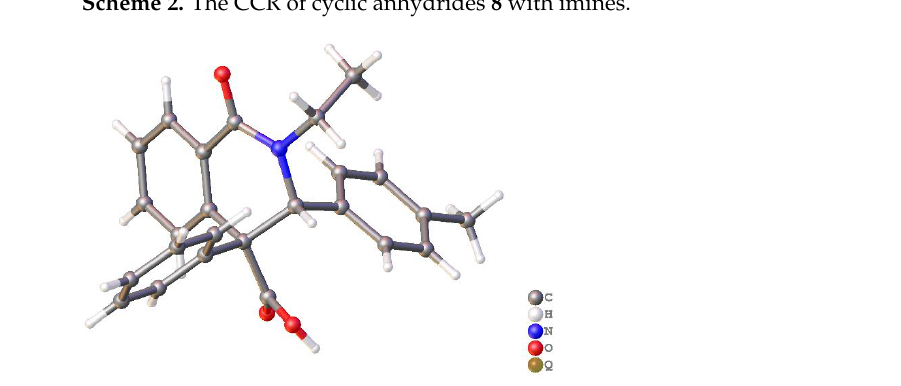
Figure 4. Crystallographic structure of compound 9a (ORTEP plot, 50% probability level).